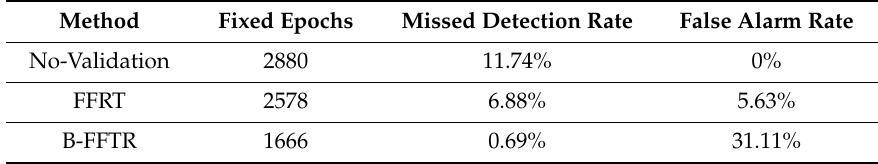
Table 1. Comparation of missed detection rate and false alarm